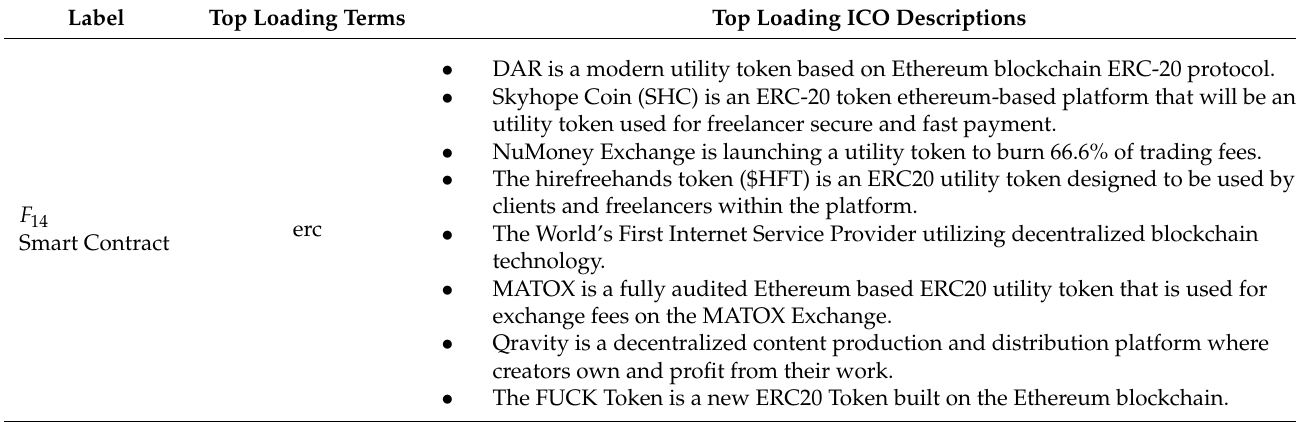
Table A14. Smart